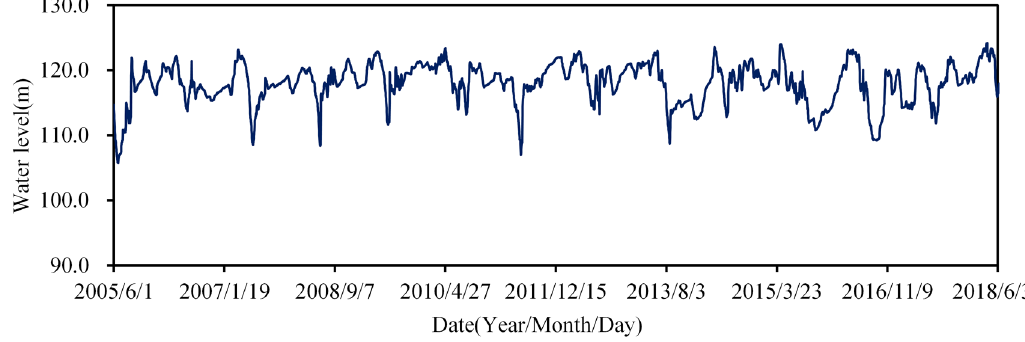
Figure 5. Water levels of Foziling reservoir.